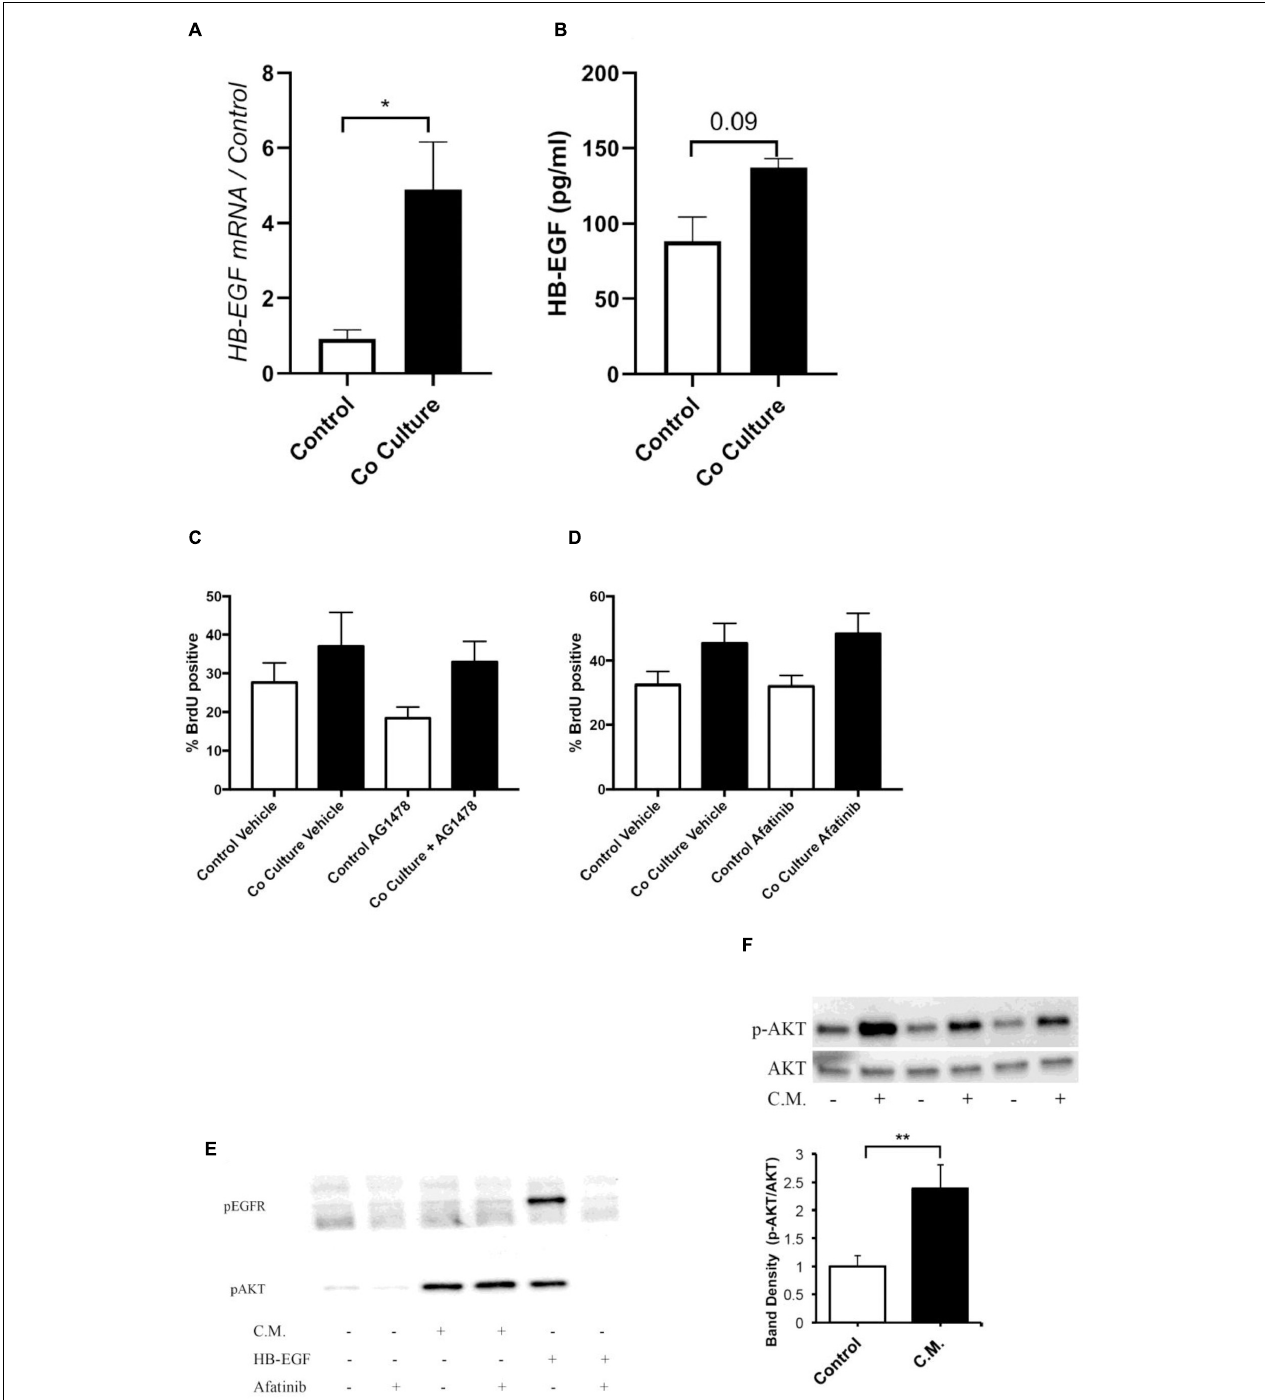
FIGURE 2 | Co-culture induced proliferation is not mediated by an epidermal growth factor receptor (EGFR) ligand. (A) ASMC expression of heparin-binding growth factor receptor (HB-EGF) was examined by RT-qPCR 24 h after co-culture with or without (control) BEAS-2B cells ( n = 4). (B) HB-EGF protein concentration was assayed in the cell culture supernatant of control or co-cultured ASMCs by ELISA after 24 h ( n = 4). (C,D) Pre-treatment of ASMCs with 0.3 µ M Tryphostin AG1478 ( C , n = 4) or 0.5 µ M afatinib ( D , n = 5) did not prevent BEAS-2B induced proliferation of ASMCs. (E) Treatment for 30 min with conditioned medium of BEAS-2B cells did not induce phosphorylation of EGFR tyrosine 1173, however, AKT was phosphorylated by conditioned medium treatment. (F) Treatment for 5 min with conditioned medium of well-differentiated human bronchial epithelial (HBE) cells induced phosphorylation of AKT. Data are representative of means + 1 SE. ANOVA with Tukey’s post hoc pairwise comparisons were employed for comparisons with more than two groups, otherwise Student’s paired t -test was utilized. * P < 0.05; ** P < 0.01.